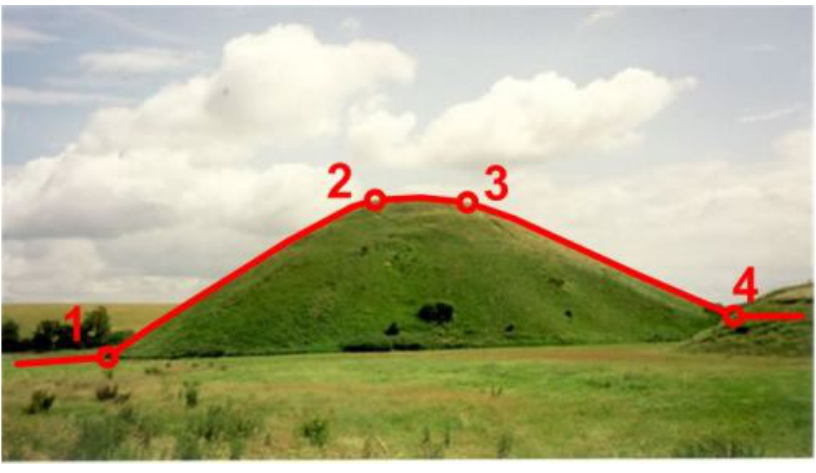
Figure 13. Four characteristic points of a cross-section along a